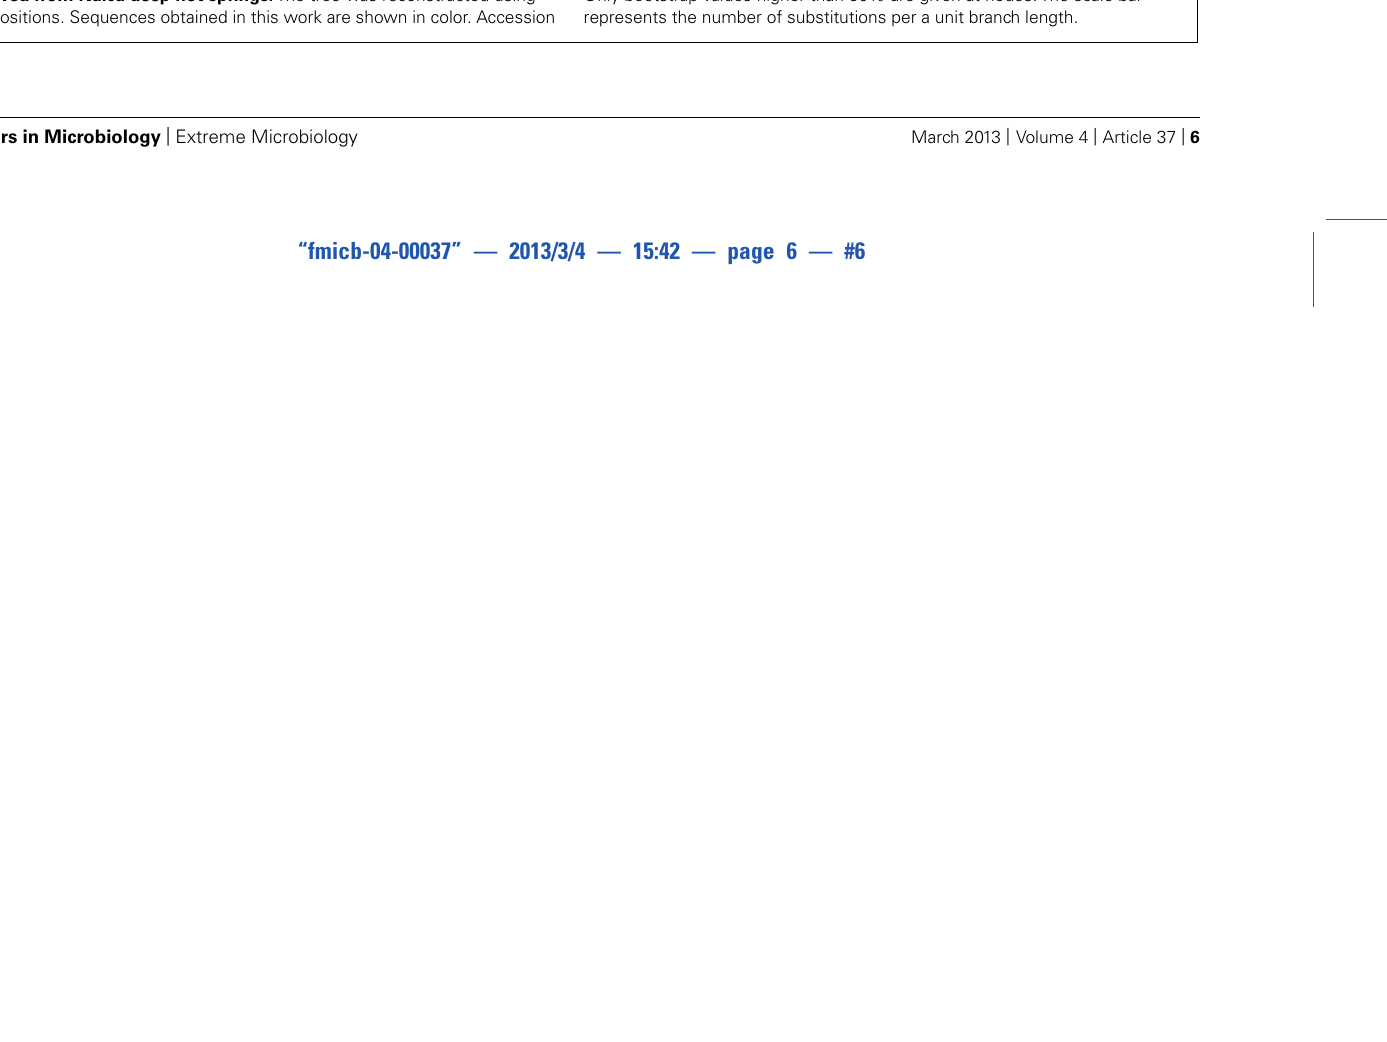
numbers of sequences retrieved from GenBank are given between brackets. Only bootstrap values higher than 50% are given at nodes.The scale bar represents the number of substitutions per a unit branch